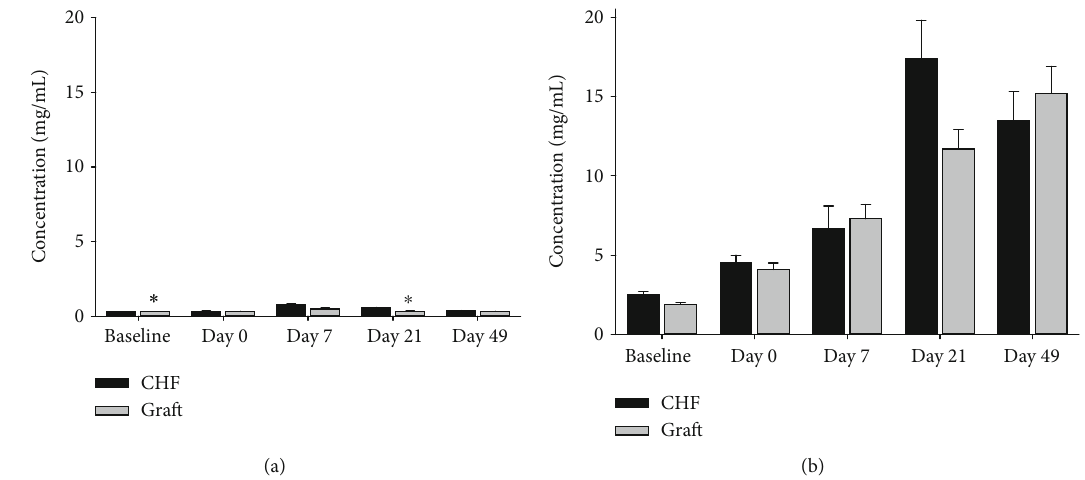
Figure 4: Rat immunologic titers. Total IgM (a) and IgG (b) values were evaluated in CHF ( n = 5 -10; black bars) rats and graft-treated rats ( n = 5 ; gray bars) at baseline (prior to infarction), day 0 (immediately prior to graft therapy), and days 7, 21, and 49 post-graft therapy. Serum IgM and IgG values for the graft-treated rats were predominately equal to the values for CHF controls with the exception of IgM at baseline and at day 21. Values are mean ± standard error of the mean. ∗ Unpaired t -test versus CHF, p < 0 : 05 revealed a physiologic shortening of the QT interval ( 78 : 6 ± 1 : 04 ms versus 101 : 2 ± 1 : 50 ms, p < 0 : 0001 ) with iso- proterenol ( n = 6 ), relative to baseline ( n = 3 ). Changes in the electrogram amplitude between electrogram waveforms is likely due to di ff erences in adhesion forces between the hydrophobic array and the engineered cardiac graft from dif- fering amounts of culture media in the petri dish (Figure 6).